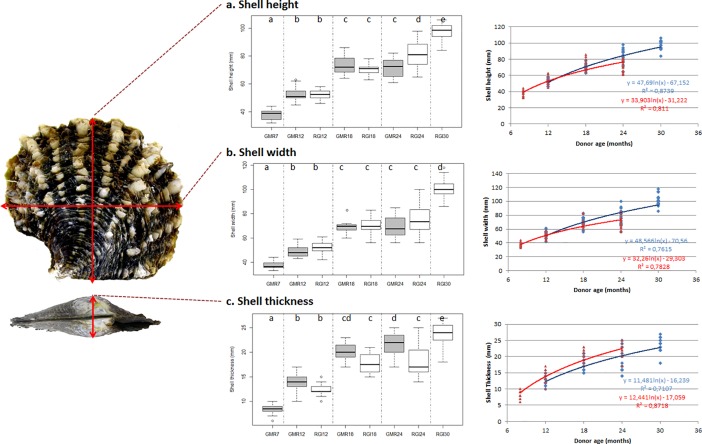
Pinctada margaritifera donor oyster shell biometric parameters.a. Shell height, b. width and c. thickness were measured at each graft time (GMR7 corresponds to 7 months old at Gambier location, GMR12 and RGI12 to 12 months old, GMR18 and RGI18 to 18 months old and GMR24 and RGI24 to 24 months and RGI30 to 30 months old at Rangiroa location). Each box-plot has the following elements: 1) median (solid bar in the box-plot); 2) 25th to 75th percentile (rectangular box); 3) 1.5*interquartile range (non-outlier range of the box whiskers); 4) minimum and maximum values (extreme dots); and 5) outlier values (outside box whiskers). Statistical differences between the age groups are indicated by letters (p < 0.05). The growth curve on the right contains two curves: Shell growth in Rangiroa in blue and in Gambier in red with their corresponding equations. Datas available on S2 Appendix.